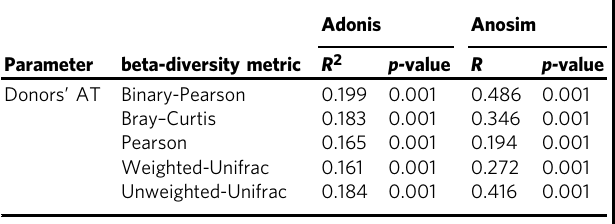
Table 2 Statistical analysis determining the in fl uence of donor polyps ’ AT on recipient